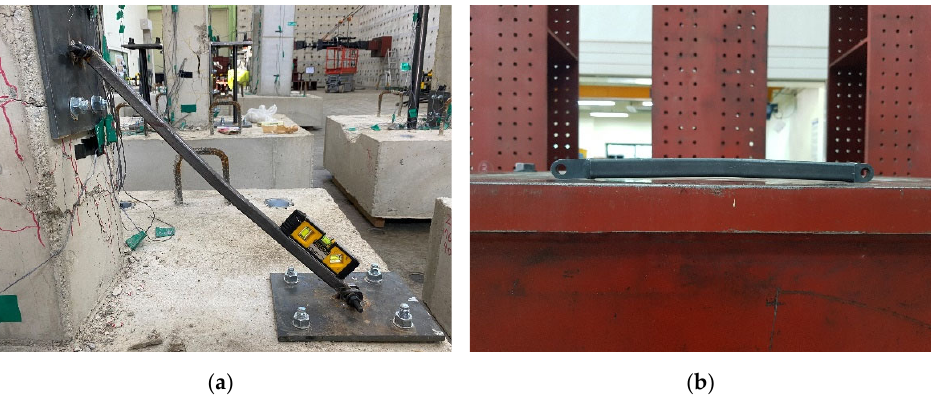
Figure 8. The buckled steel links: ( a ) Buckled steel link of R-575 specimen; ( b ) Buckled steel link of R-375 specimen after detaching.